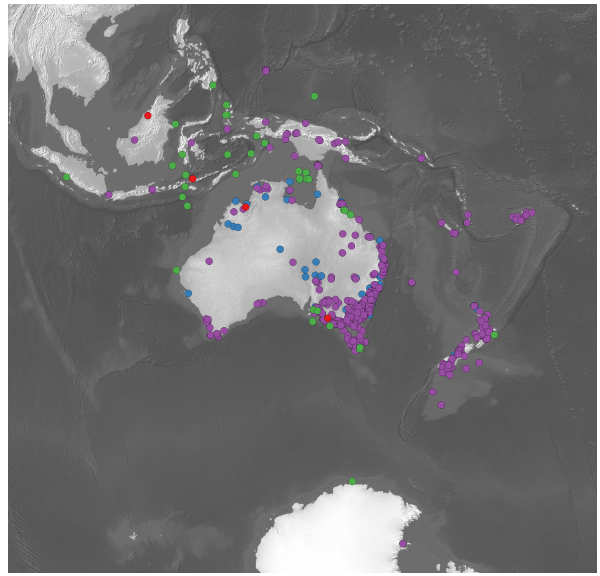
Figure 1. Map of all Australasian records identified. Each marker represents one record location. Archive types are represented by colour for lake/wetland/peat (purple), marine (green), speleothem (red), and geomorphic (blue) archive